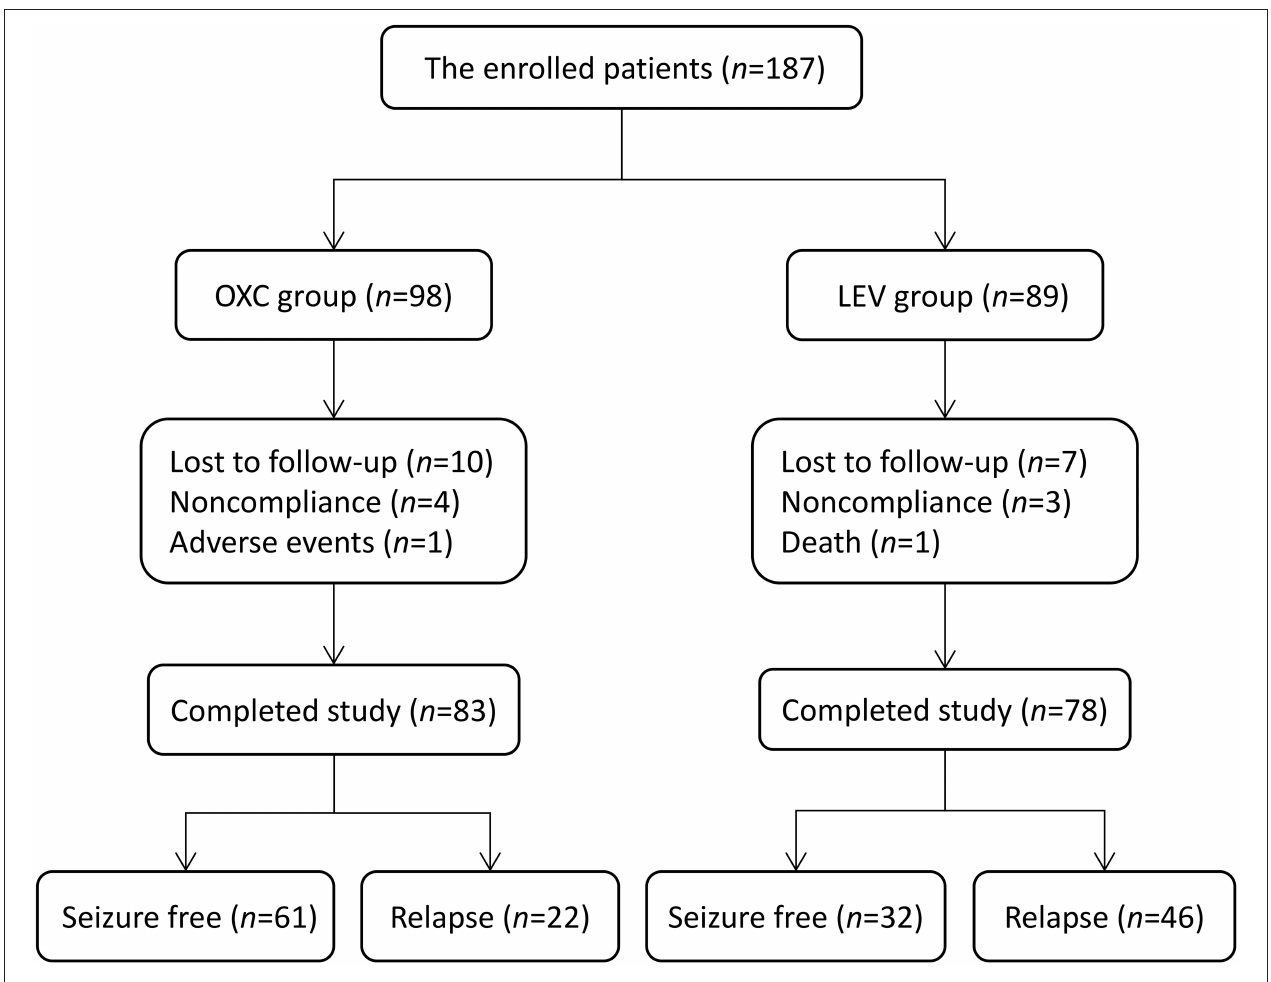
FIGURE 1 | Flowchart depicting the overall outcomes of the study cohort. OXC, oxcarbazepine; LEV,